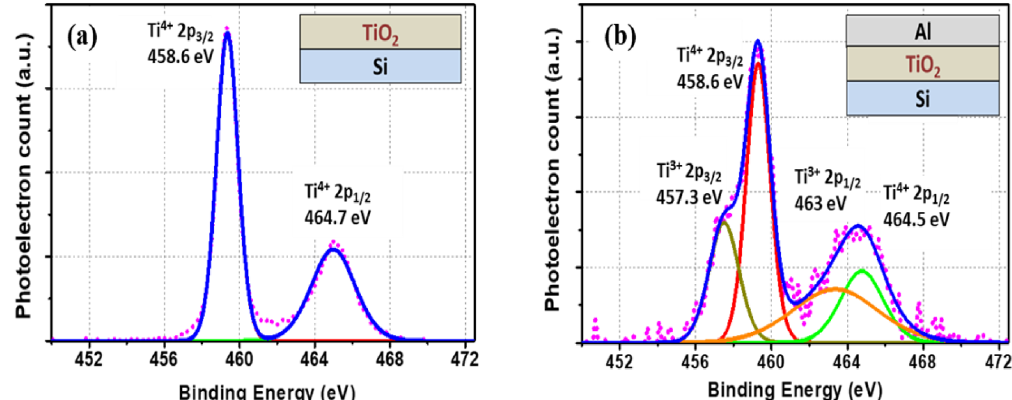
Fig. 7. XPS Ti(2p) core energy region of solution-processed TiO 2 on n-Si (a) before and (b) after